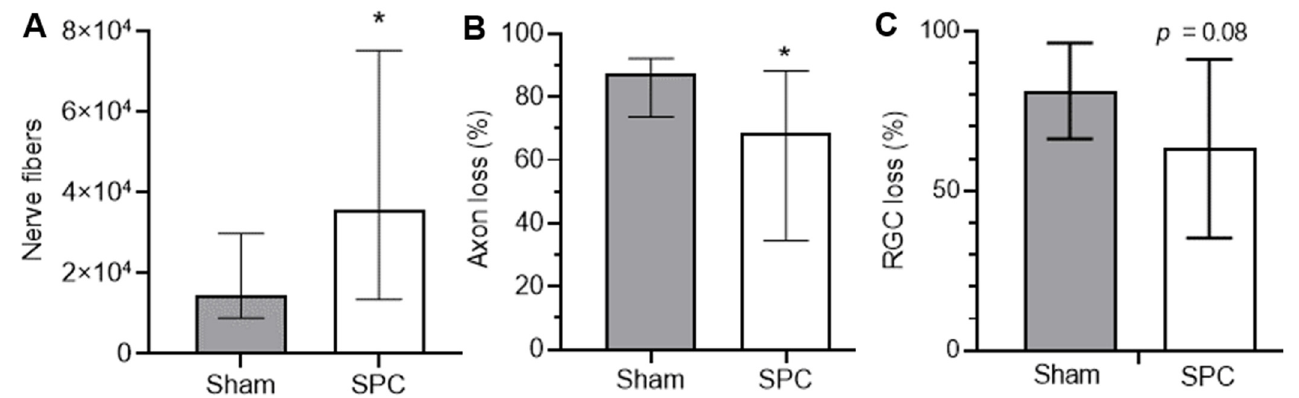
Figure 4. SPC microcrystals preserve nerve fibers and axons. A single unilateral subconjunctival injection of SPC microcrystals (200 µ g in 5 µ L) or vehicle (Sham) was prior to laser induced hypertension ( n = 15–16). Optic nerves were evaluated for ( A ) number of nerve fibers and ( B ) percent reduction in nerve axons. Data shown as median ± IQR. * p < 0.05. Statistical analyses conducted by Wilcoxon rank sum test for two independent groups. ( C ) Retinal ganglion cell (RGC) loss was reduced with SPC microcrystals ( n = 7) compared to untreated animals ( n = 12), but not statistically significant ( p = 0.08) due to variability and loss of tissues during the staining process. Data shown as mean ± SD. Statistical analysis conducted by unpaired t-test.